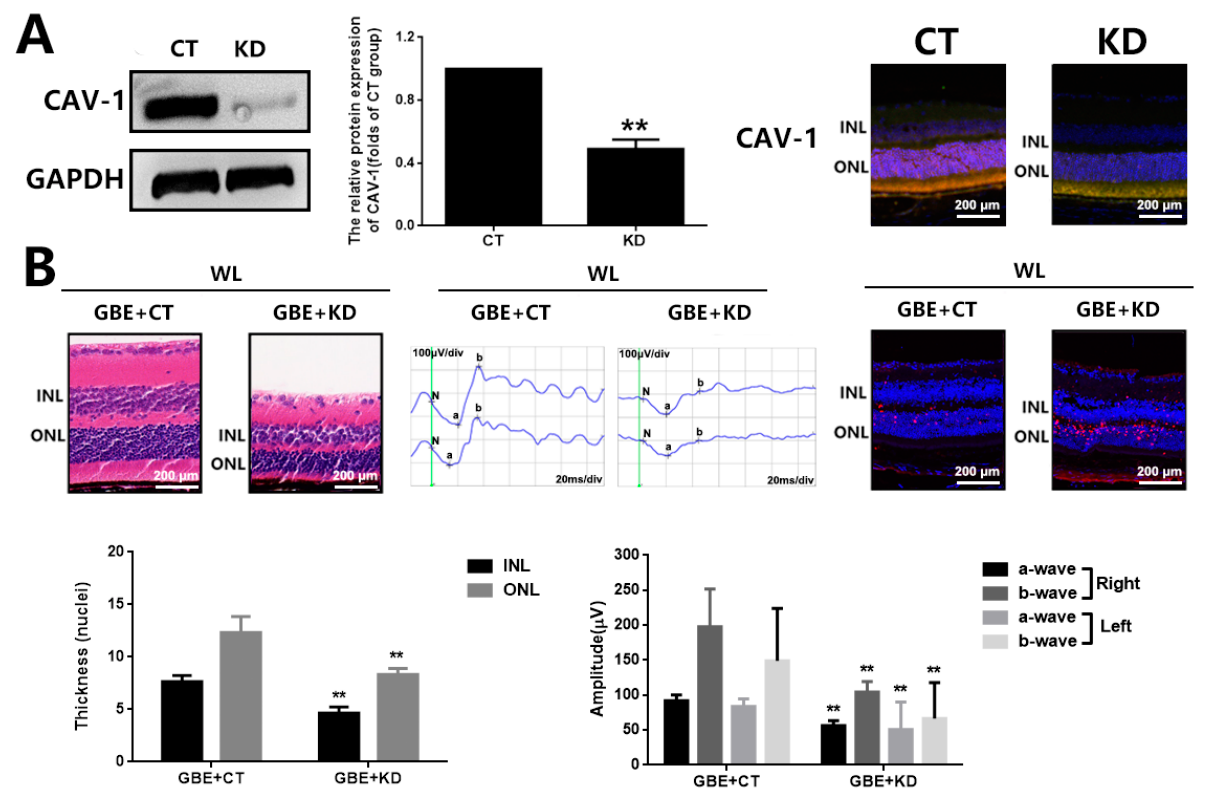
Figure 9. CAV − 1 silencing attenuated the protective effect of GBE on photoreceptor degeneration in C57BL/6J mice exposed to WL illumination. ( A ) The silencing of CAV − 1 in mouse retinas was verified by Western blot analysis (left and middle panels) and immunofluorescence staining (DAPI: blue fluorescence, CAV − 1: red fluorescence, rhodopsin: green fluorescence) (right panel). ( B ) Mice with or without CAV − 1 silencing were orally administered GBE (100 mg/kg body weight/day for 5 days) and then exposed to WL (50,000 lux) for 8 h/5 days with continuous GBE treatment. Retina structure was assessed by HE staining (left panel). Retina function was assessed by ERG analysis (middle panel). Photoreceptor apoptosis was assessed using TUNEL staining in the right panel (TUNEL: red fluorescence, DAPI: blue fluorescence). ** p < 0.01 vs. GBE + CT. WL: white light, INL: inner nuclear layer, ONL: outer nuclear layer, CT: Control, KD: CAV − 1 silencing.